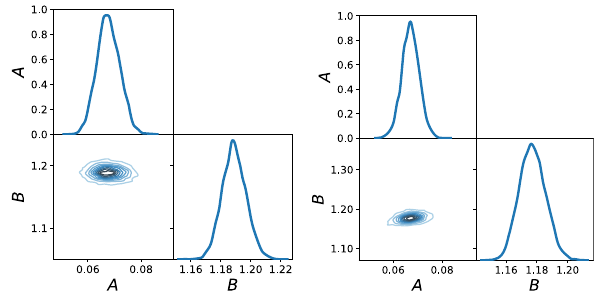
Fig. 6 The posterior distribution of the parameters A and B in the strong coupling α s ( E ) , using two different g ( T ) obtained in Sect. 2 from fitting to WB (Left) and HQ (Right) lattice QCD data Table 4 The mean and standard deviations of parameters ( A , B ) in the coupling α s ( E Q ) extractedfrom R AA and v 2 usingWuppertal–Budapest and Hot QCD EOS Lattice data